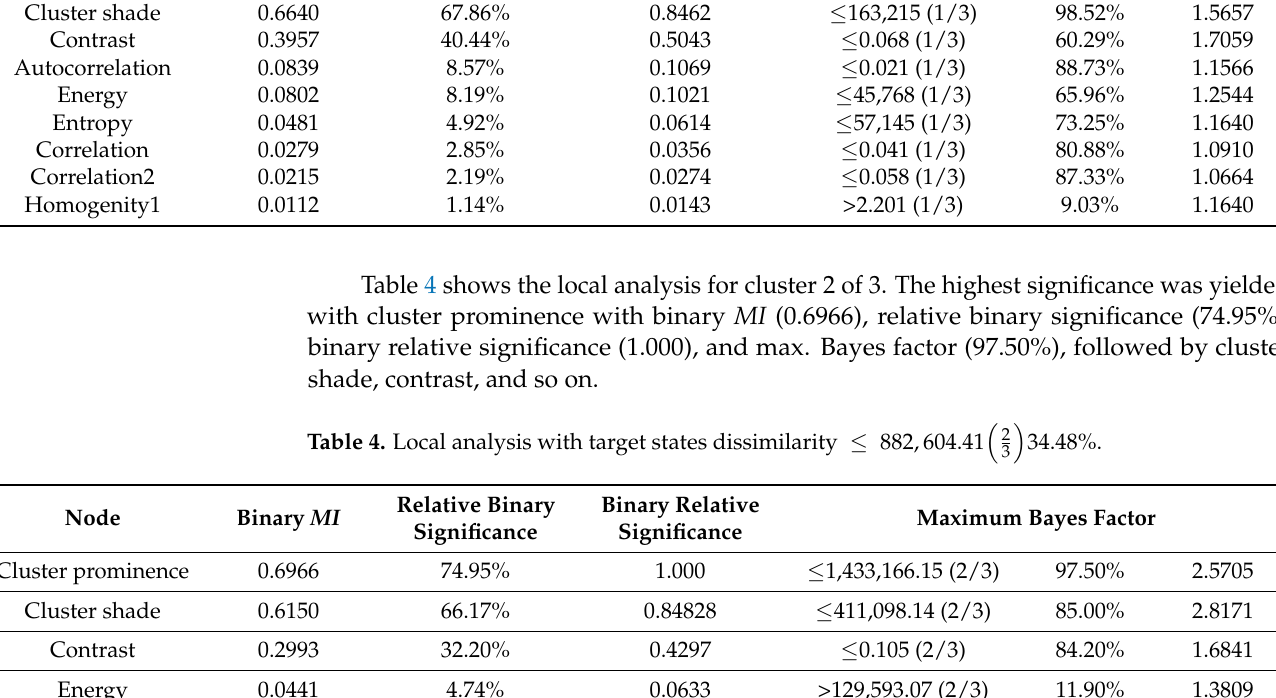
Table 3. Local analysis with target states dissimilarity ≤ 349,738.09